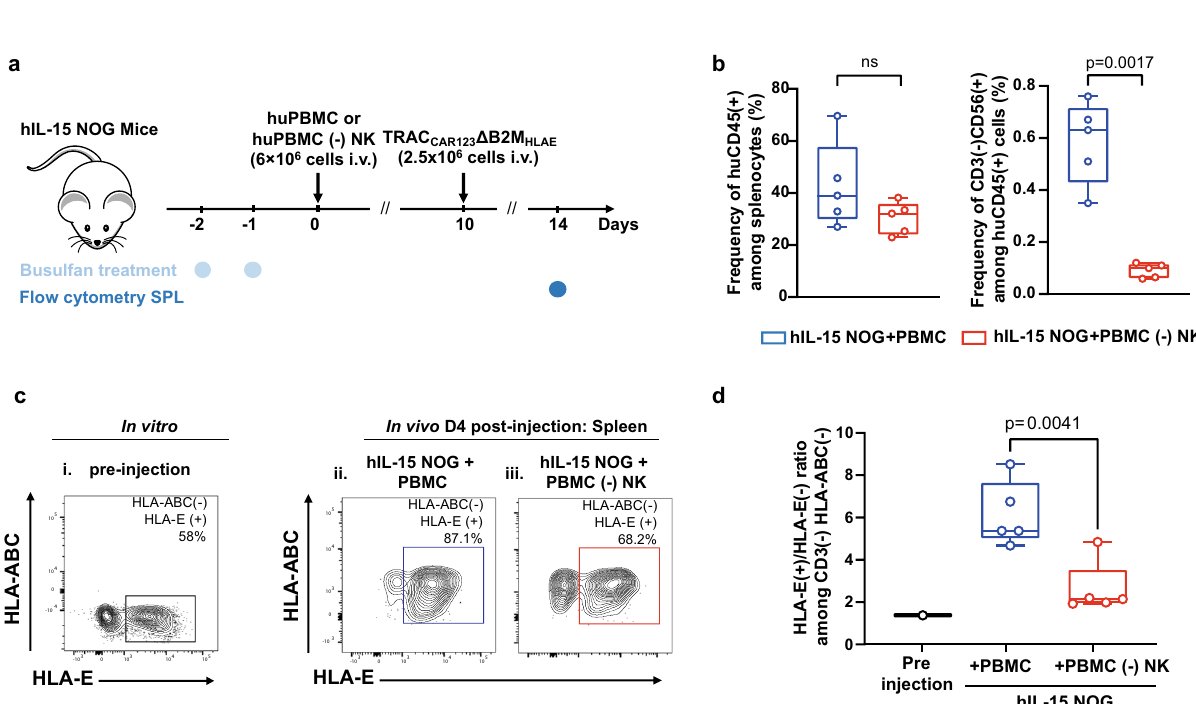
Fig. 5 Deep phenotyping and functional characterization of NK cells from healthy donors and AML or ALL patients undergoing standard induction chemotherapy. a Total lymphocytes obtained from healthy donors (HD, n = 8), newly diagnosed ALL patients (ALL D, n = 23) and AML patients selected at the time of diagnosis (AML D, n = 27), complete remission (AML CR, n = 8), and in relapse/refractory status (AML R/R, n = 11) were characterized using mass cytometry. b Frequencies of NK-cell subsets among total lymphocytes (left panel), frequencies of NKG2A( + ) and NKG2C( + ) subpopulations among total NK-cell subset (middle panel), and ratio of NKG2A( + ) over NKG2C( + ) subpopulations (right panel) characterized by mass cytometry. For quantitative comparisons, data were analyzed using an ordinary one-way ANOVA test, a tukey ’ s multiple comparison test with single pooled variance and a con fi dence interval of 95%. c , d For each group described in a , NKG2C( − ) and NKG2C( + ) NK cells from each individual were exported and concatenated in order to generate consensus fi les. c The optimized parameters for T-distributed stochastic neighbor embedding (opt-SNE) algorithm were used to cluster NK-cell populations based on the expression of markers of interest in healthy donors and in AML patients at the time of diagnosis (left panel). Expression of markers of interest de fi ning the different clusters are projected on opt-SNE maps (right panel). d The heatmap displays the mean frequencies of NK-cell markers in NKG2C( − ) and NKG2C( + ) NK cells, relative to pooled NKG2C( − ) and NKG2C( + ) NK cells. e Schematic showing the experimental design to investigate the susceptibility of Δ TRAC CAR123 Δ B2M and Δ TRAC CAR123 Δ B2M HLAE cells ( n = 1 T-cell donor), engineered using optimal conditions, to NK-cell-dependent depletion in vitro using PBMC from healthy donors ( n = 7) AML patient ( n = 7) at diagnostic. f Box plots represent the ratio of Δ TRAC Δ B2M and Δ TRAC Δ B2M CAR123 CAR123 HLAE counts obtained in the presence of PBMCs over the counts obtained in the absence of PBMCs. Dotted lines indicate data obtained from the same PBMC donor. In each box plot, the central mark indicates the median, the bottom and top edges of the box indicate the interquartile range (IQR), and the whiskers represent the maximum and minimum data point. For quantitative comparisons, data were analyzed using a two-sided non-parametric Wilcoxon matched-pairs signed-rank test with a con fi dence interval of 95%. P values are indicated on the fi gures. Source data are provided as a Source Data fi le.